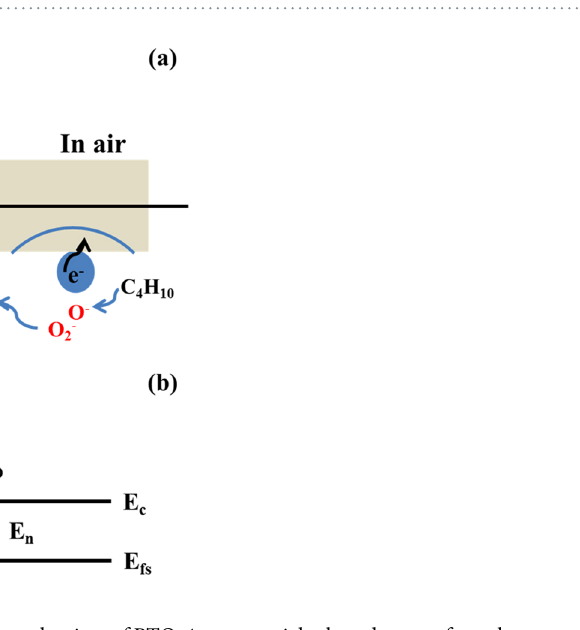
Figure 10. A schematic diagram of the mechanism of PTO-4 nanoparticles based sensor for enhancement caused by metal-semiconductor; Grey represent TiO 2 nanoparticles; the blue represent palladium